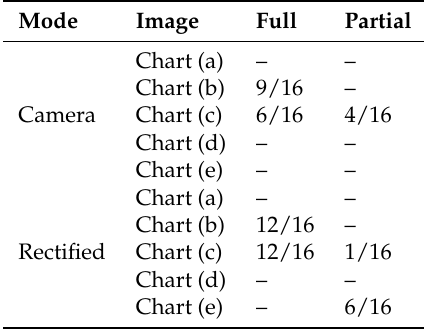
Table 6. Results for chart recognition applied to the images of the book based on two approaches: normal and rectified, for full and partial detection. Each image has 15 other versions, varying by slight rotations. Charts (a) and (d) got no detection in any mode. Rectified images got better detection results for other